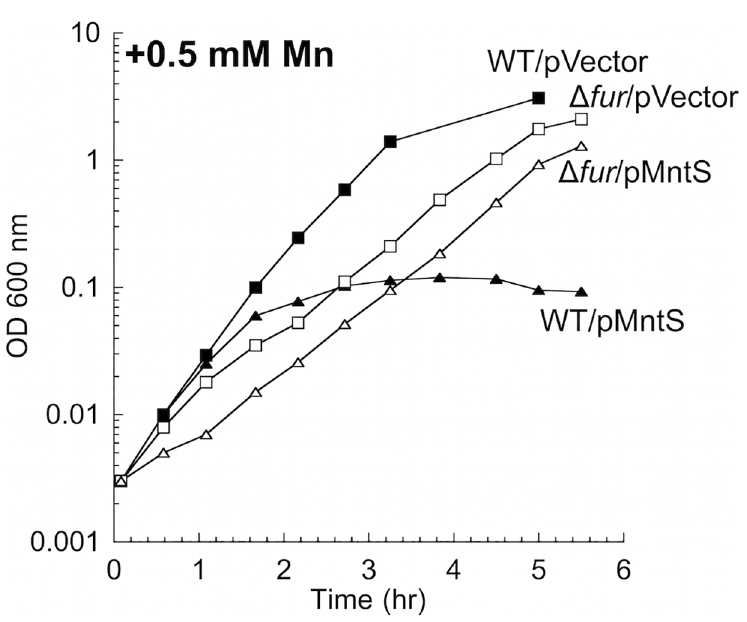
Fig 4. MntS-overproducing cells are manganese sensitive. Cells were pre-cultured in aerobic LB medium and then diluted at time zero into fresh LB/arabinose medium containing 0.5 mM MnCl 2 . Strains were MG1655 (WT) and JEM913 ( Δ fur ) harboring empty vector (pBAD24) or pMntS (pLW112, mntS driven by the araBAD promoter). The data are representative of at least three independent